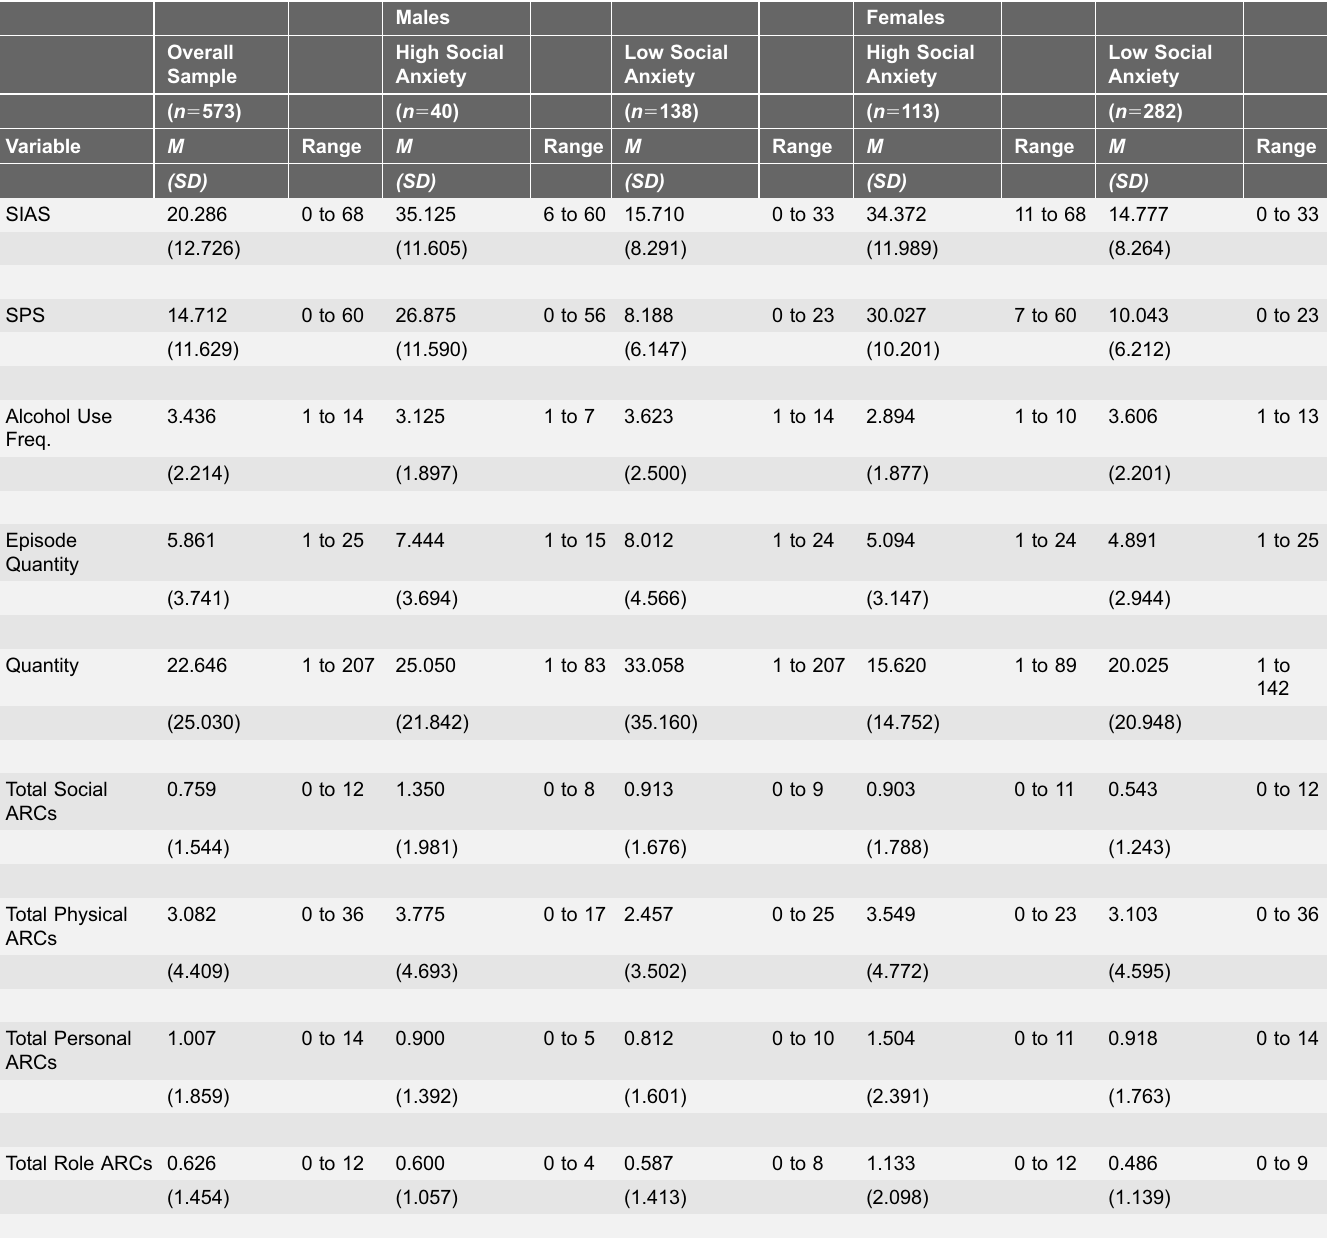
Table 1. Descriptive